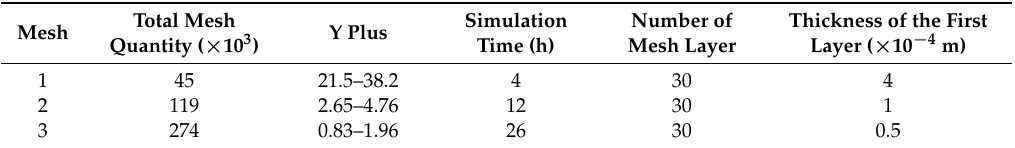
Figure 7. Variation trend of torque coefficient of single turbine with phase angle for three different timesteps 4.1.3. The Effects of Side Wall and Wall Category Researchers have not drawn a unified conclusion about the category of wall and the distance between the wall and center of the turbine used in specific numerical simulations [38–39]. Therefore, the influence of wall category (slip wall and non-slip wall) and the distance D w (distance between the side wall and center of the turbine) on the hydrodynamic performance of the turbine is investigated in this paper. Five different D w , namely 0.75D, 1D, 2D, 4D, 8D, are chosen to investigate the influence of side wall effects on the hydrodynamic performance of the turbine. Two different wall categories are chosen to investigate the influence of wall category on the hydrodynamic performance of the turbine. Figure 8 and Figure 9 shows the torque coefficient of a slip wall and a non-slip wall at different D w . As Figure 8 and Figure 9 shows, the peak value of torque coefficient decreases with the increase of D w . Deviation of torque coefficient is very big when D w is less than 6D. The torque coefficient curve is almost the same when D w is 6D and 8D, respectively. Therefore, when the distance between side wall and center of the turbine is bigger than 6D, the effects of side wall can be neglected. Figure 8 and Figure 9 shows the average C q curve of the turbine with a slip wall and